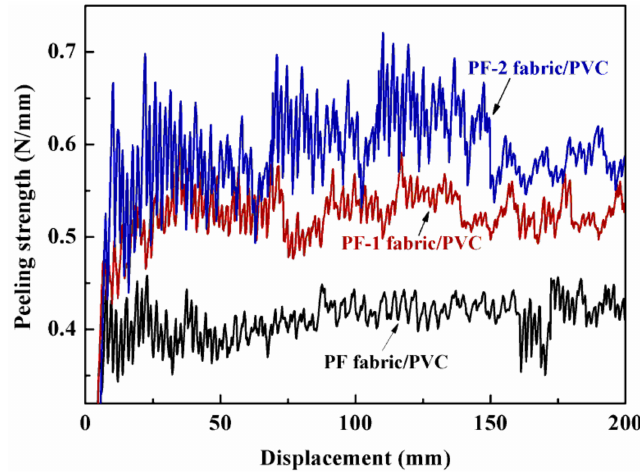
Figure 11. Typical peeling curves of PET fabric/PVC